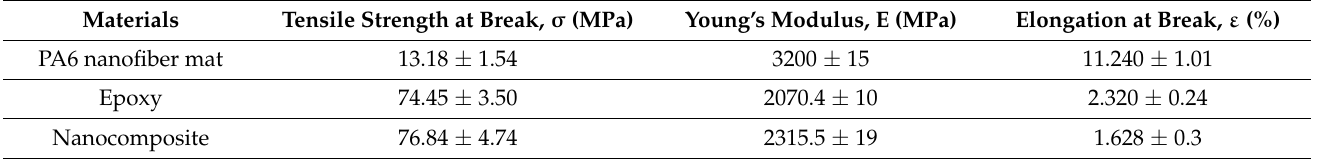
( b ) Figure 7. Stress–strain curve. ( a ) PA6 nanofiber mat; ( b ) epoxy and layered composite. Table 1. Mechanical properties of the PA6 nanofiber mat, epoxy, and layered composite. Materials